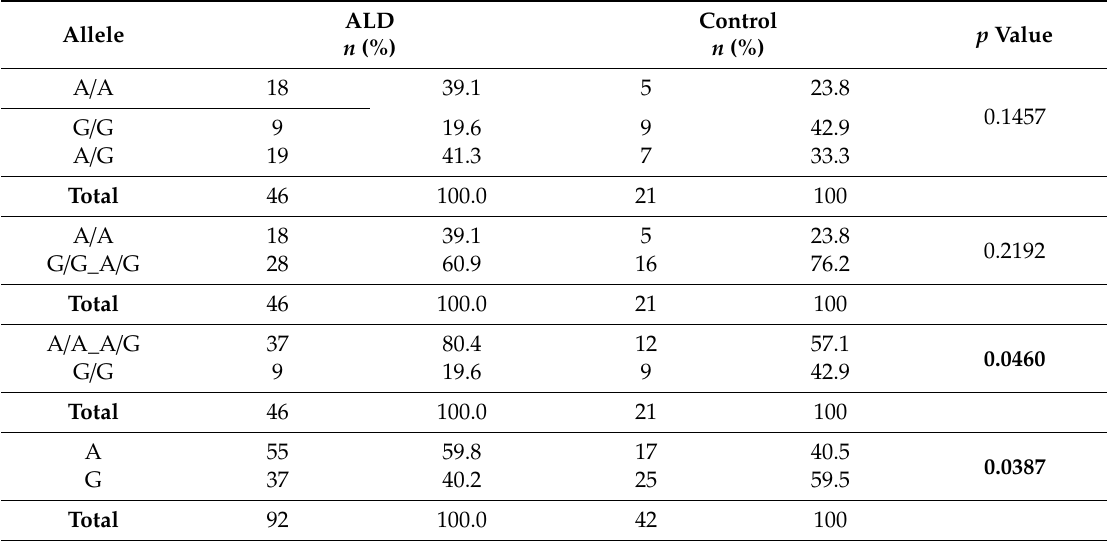
Table 1. Allele Frequencies Compared to Alcoholic liver disease (ALD) / Control Groups—SNP rs35652124 (-214 A > G).